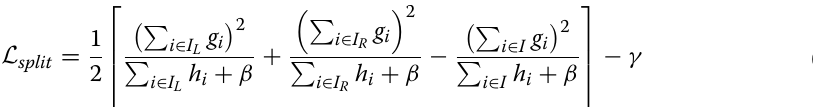
Table 3 In each run, a random combination of hyperparameters is tested Hyperparameter Space Distribution N estimators Learning rate Colsample